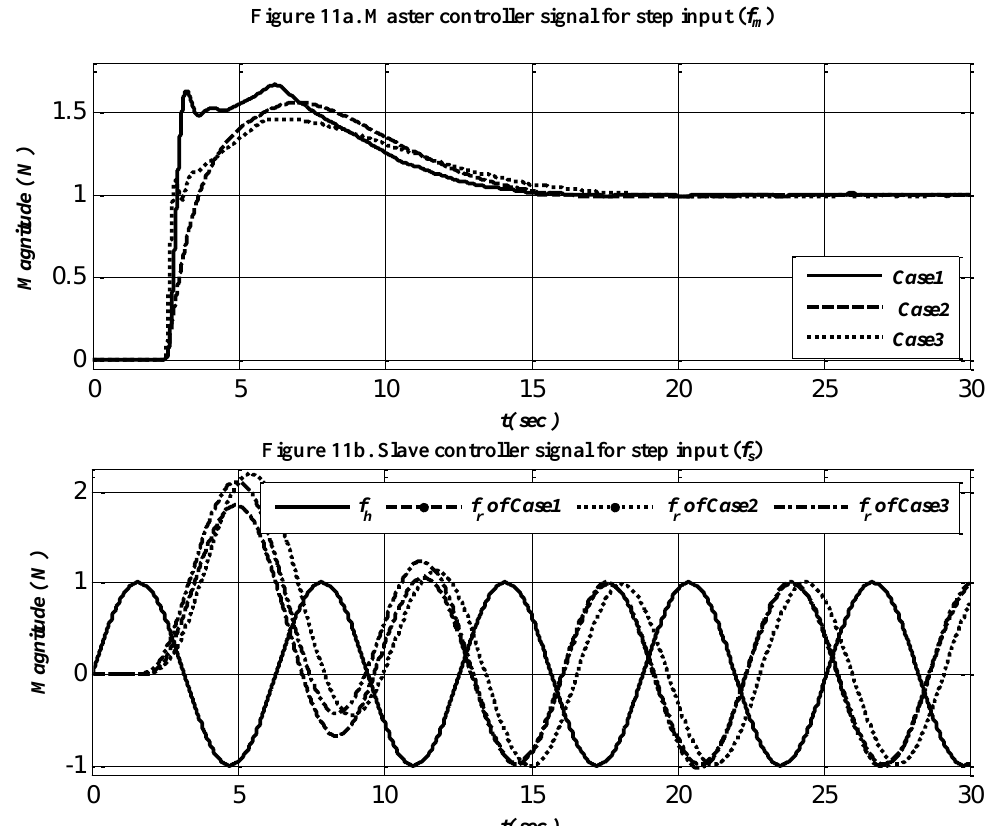
Figure 11b. Slave controller signal for step input ( f s )